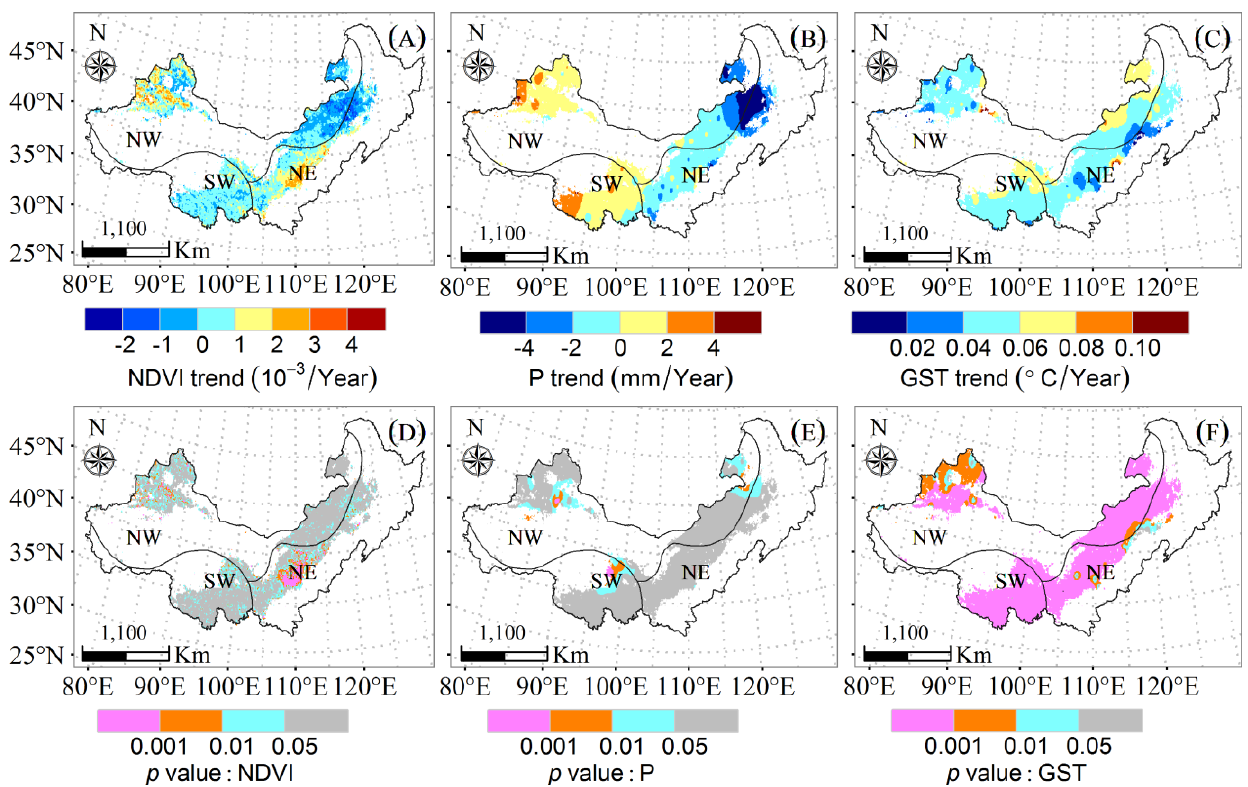
Figure 3. Changes in mean growing season NDVI ( A ); annual precipitation (P) ( B ); growing season temperature (GST) ( C ); and the corresponding statistical p values for NDVI change ( D ); precipitation change ( E ); and GST change ( F ), respectively, in northern China during the period